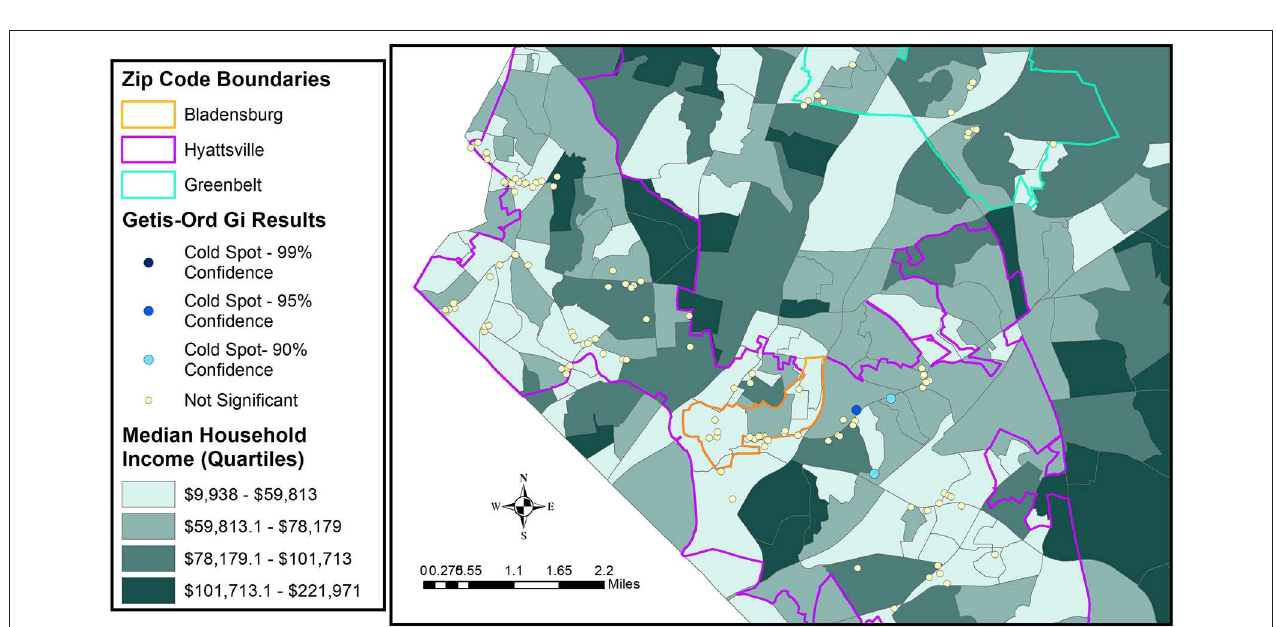
FIGURE 2 | Distribution of hot and cold spots clusters in Bladensburg, Greenbelt, and Hyattsville, MD (2018).